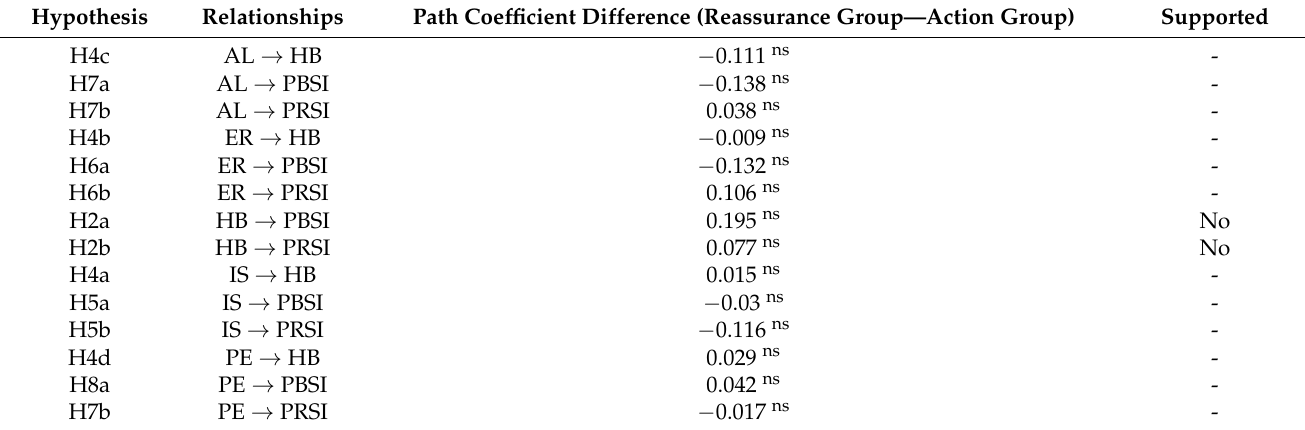
Table 7. Results of MGA.